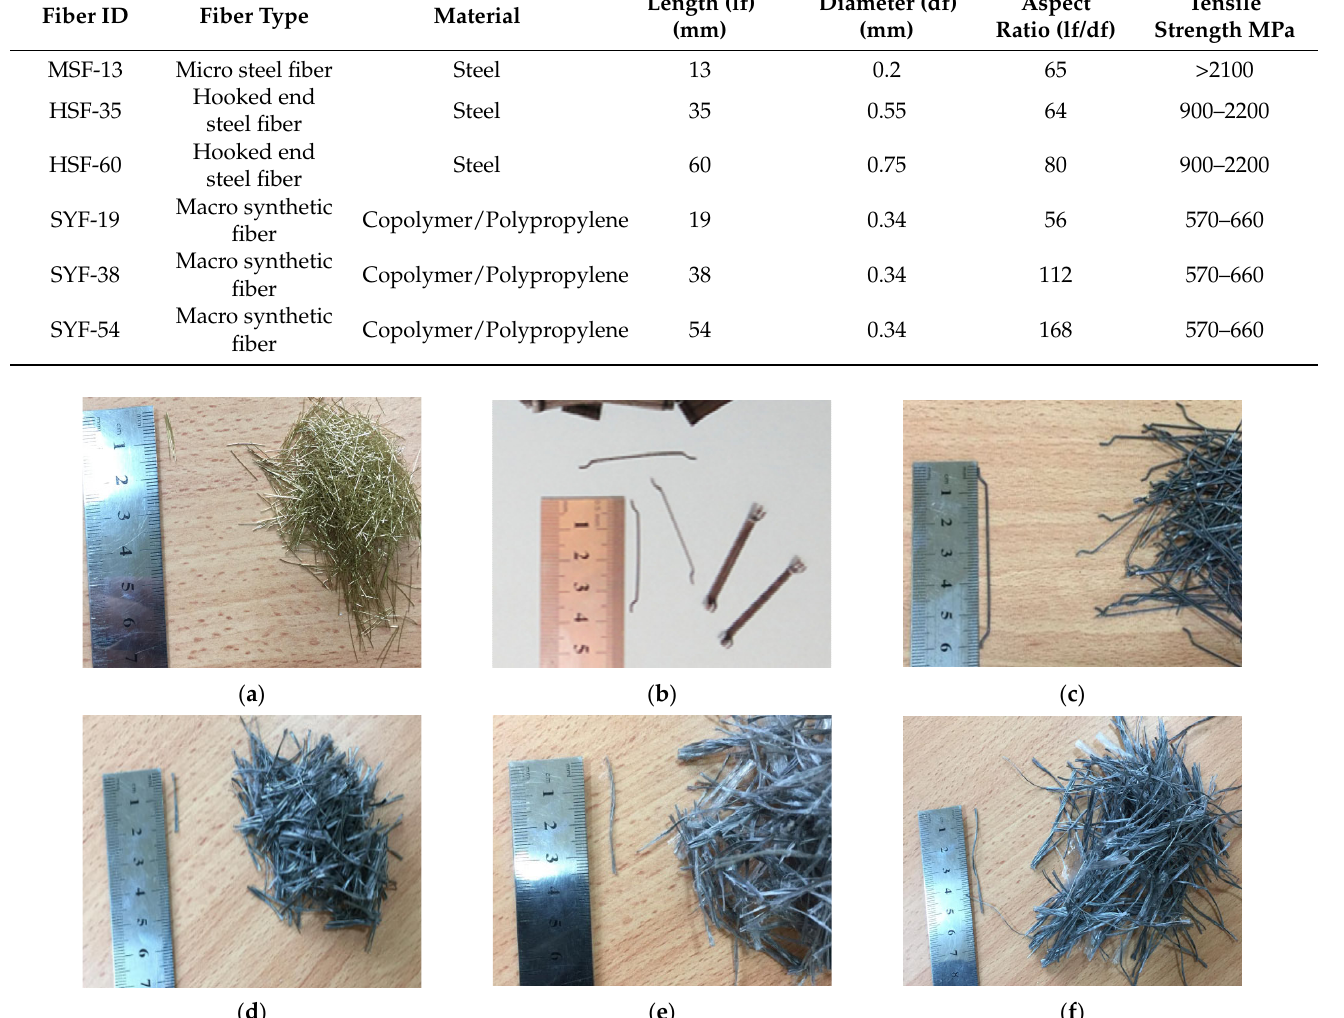
Table 5. Properties of fibers provided by the manufacturer.